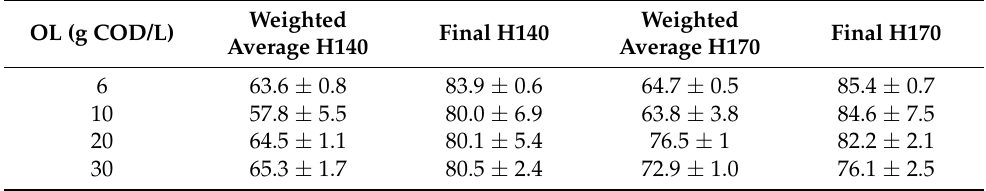
Figure 6. Methane content in biogas produced at varying organic loads (OLs) with time in syringes fed H170. COD = chemical oxygen demand. Table 6. Weighted average and final methane content of biogas in syringes.